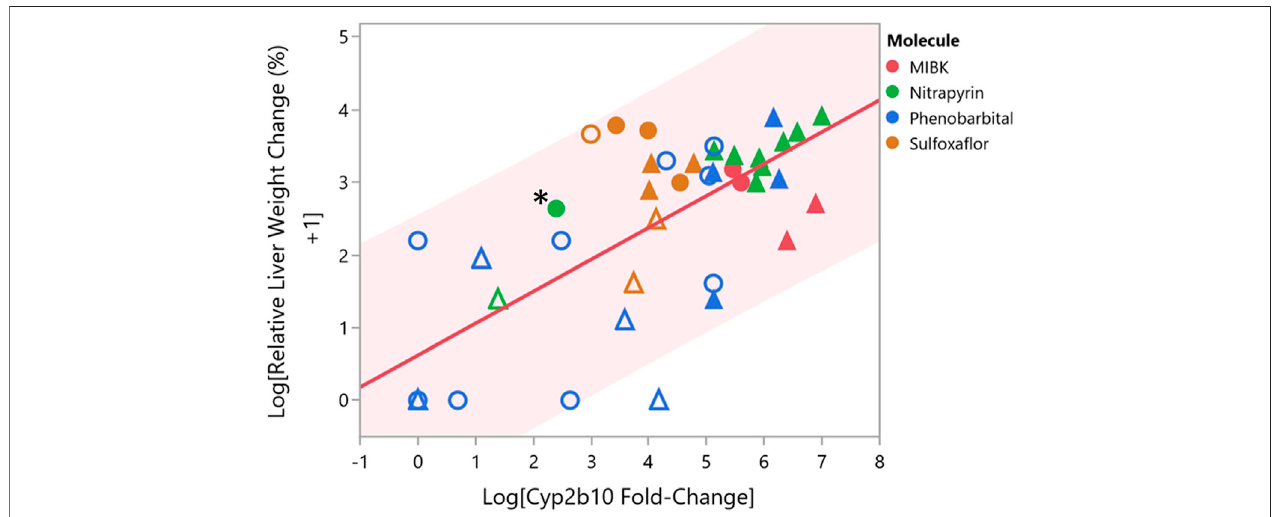
FIGURE 3 | Comparison of Cyp2b10 Gene Expression and Relative Liver Weight Changes for Male and Female Mice and Rats Following Exposure to CAR Activators Nitrapyrin, MIBK, Phenobarbital, or Sulfoxa fl or. Comparison of log relative liver weight change (percent) and log Cyp2b10 fold-change gene expression for male and female mice following exposure to either nitrapyrin (green), MIBK (red), phenobarbital (blue), or sulfoxa fl or (orange) for 90-days or less. Each data point corresponds to a single dose level for one sex. Male mice are represented by triangles, and female mice are represented by circles. Data points that are fi lled correspond to dose levels that are at or above the tumorigenic dose for the respective molecule, and data points that are un fi lled correspond to dose levels below the tumorigenic dose for the respective molecule. The data point for female mice exposed to nitrapyrin at 125 mg/kg/day is indicated by an adjacent asterisk. Shading from the trend line corresponds to the 95% prediction